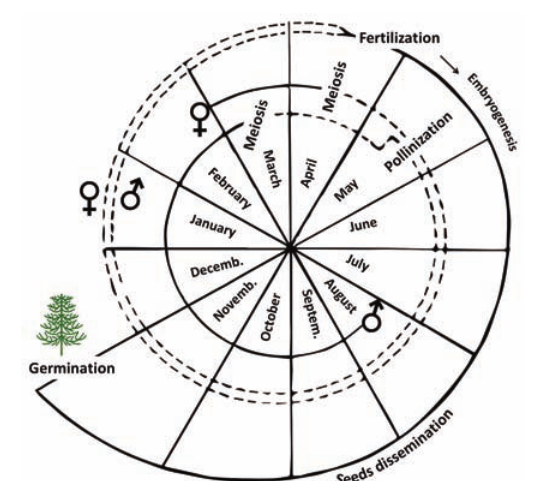
Fig. 6 - Schematic representation of the ontogenetic cycle of Araucaria araucana . Solid lines represent diploid phases (female and male gametogenesis) and embryogenesis after fertilization, while dashed lines represent haploid phases (ovules and pollen). (From Favre-Duchartre, 1960,